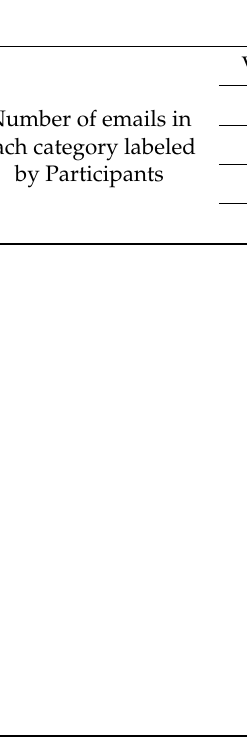
Table 4. Test Result—Labeling emails without proposed mechanism. Number of Emails in Each Category Labeled by Requesters